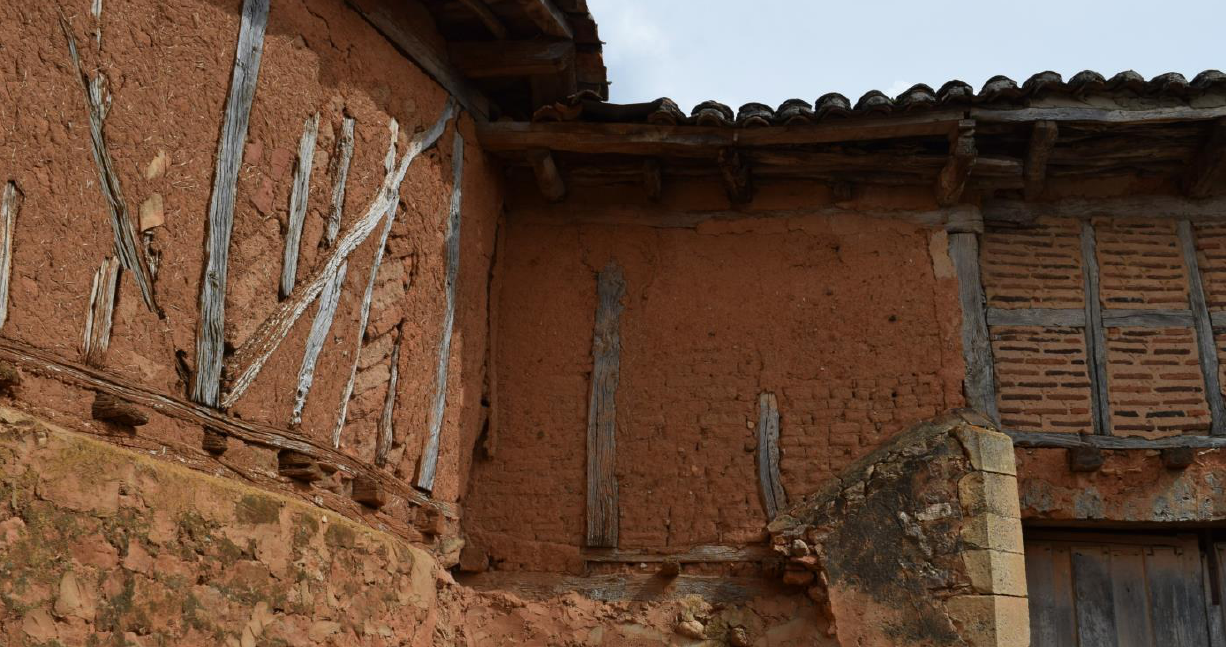
Figure 25. Half-timber wall with heavy adobe filling, where the wood used for the construction of the framework must meet minimum mechanical resistance requirements. Building located in Pedro de Ojeda (Palencia), with the sample PA1 analysed and identified as belonging to the Populus genus . The timber framework is made up of main vertical elements known as uprights, which are connected at the ends to other main horizontal elements, known as beams, sills, or wall plates, depending on their position. While the vertical elements are subject to a greater extent to compression parallel to the fibre of the timber, the horizontal elements are subjected to stress when there is no filling in the lower space and to bending strength perpendicular to the fibre when there is filling both in the upper and lower sections.